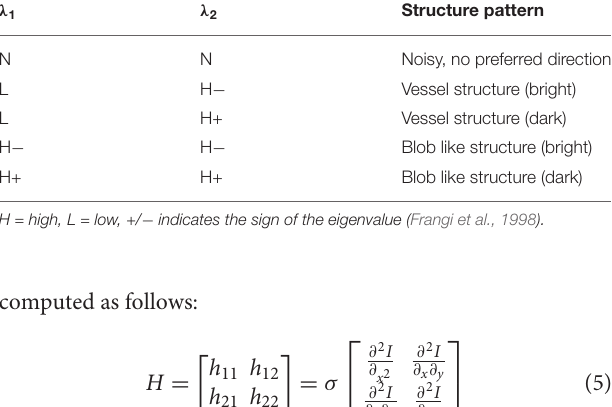
and λ 2 . λ 1 Structure